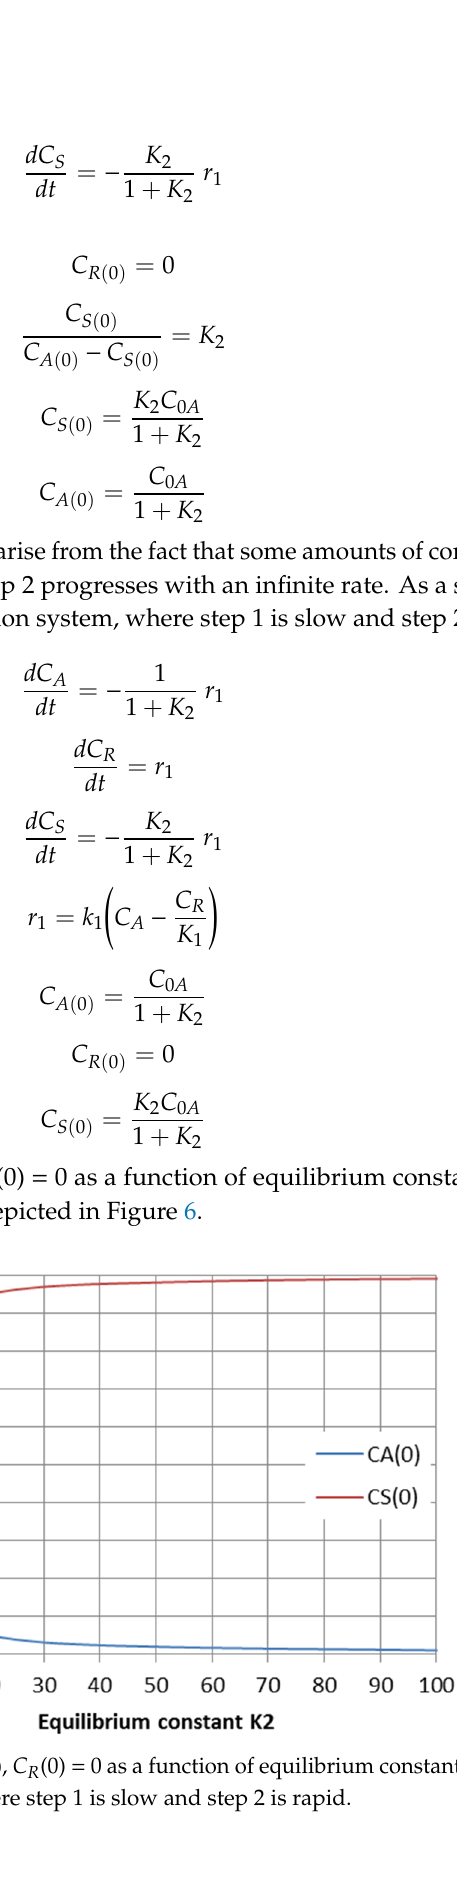
Figure 7. Concentration profiles of the special case of a parallel reaction system with parameters: k 1 = 1, K 1 = 10 and K 2 = 2. The general case of a parallel reaction system was compared with the special case as in the previous example 2.1 by increasing the value of the rate parameter k 2 of the rapid reaction step 2 to find the value of k 2 by which the solution of the general case approaches that of the special case. Concentration profiles for the general case of parallel reactions corresponding to k 2 values of 2, 10 and 50 are depicted in Figure 8.